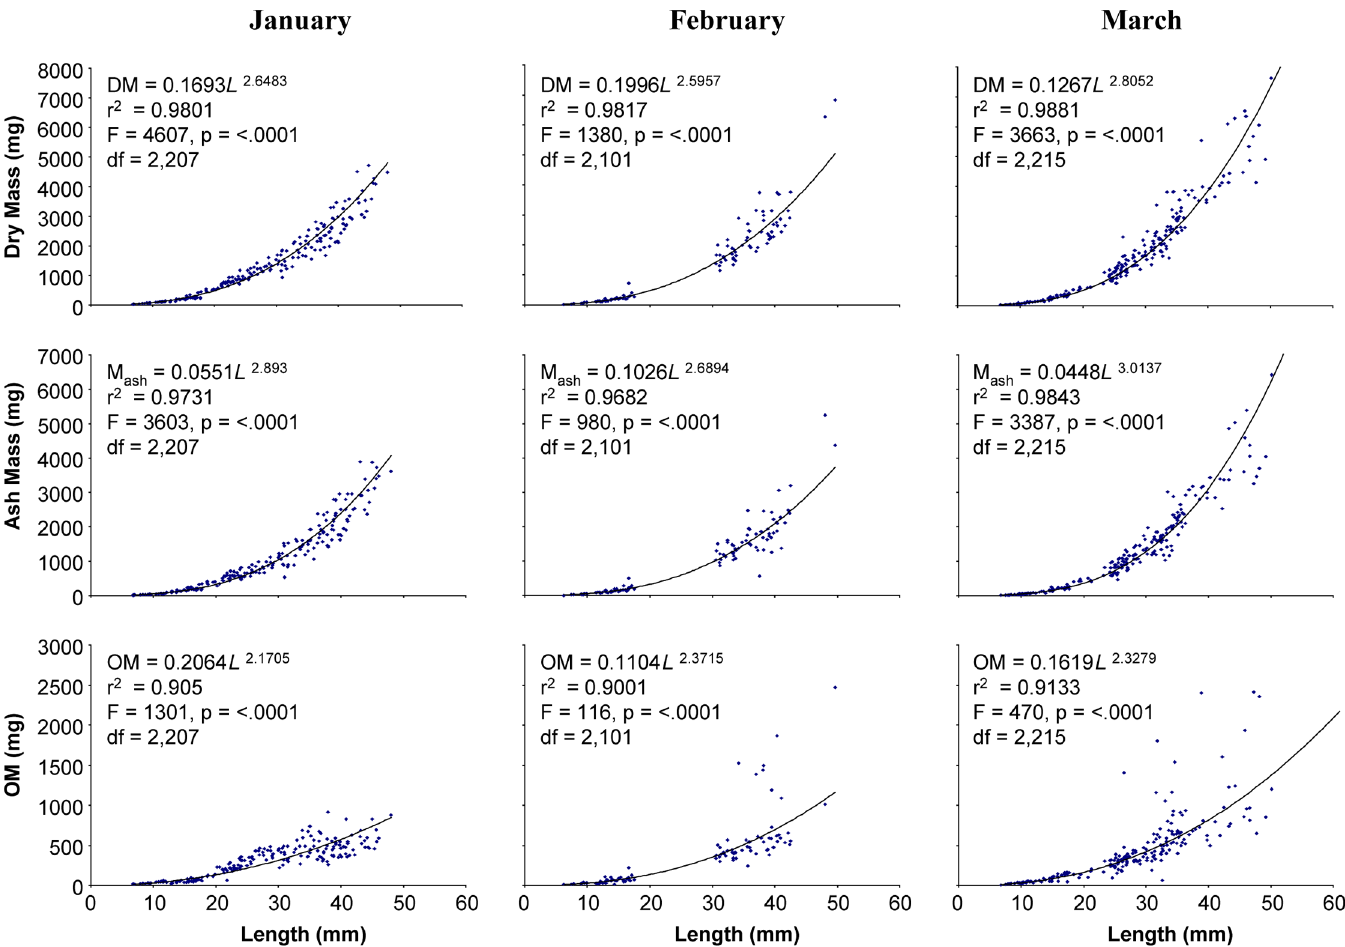
Fig 1. Dry, ash, and organic matter masses of Ischadium recurvum collected in winter relative to shell length. Dry mass (DM; mg), ash mass (M ash ; mg), and organic matter (OM; mg) of Ischadium recurvum (including shell) as a function of length (mm) collected from the Chesapeake Bay in January, February, and March 2007. All regressions were significant at the 5% level (p <